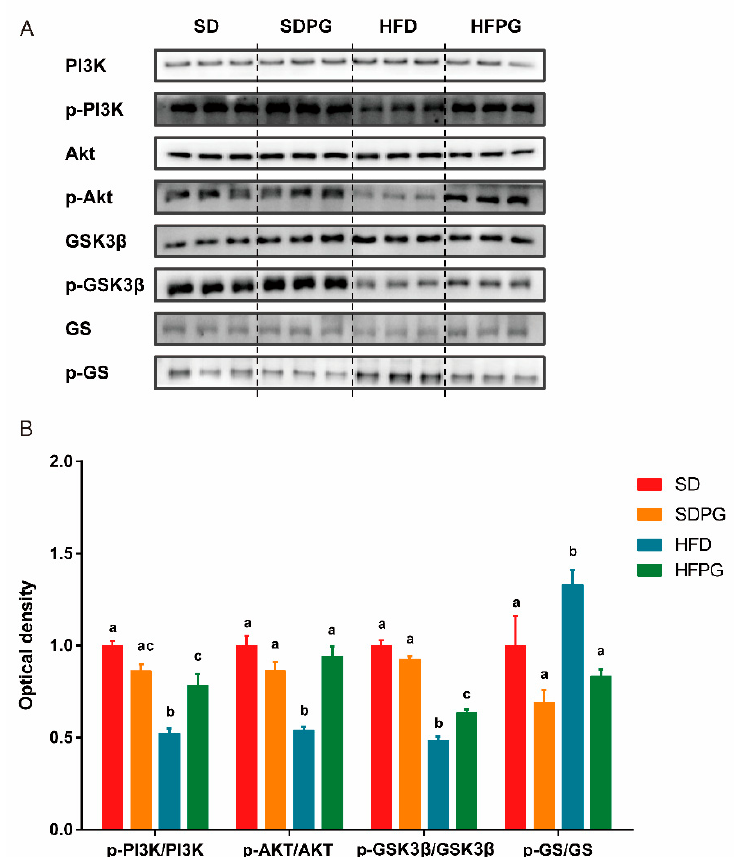
Figure 4. PG enhances hepatic insulin signaling PI3K/Akt/ GSK3 β pathway in HFD-fed mice. ( A ) Western blot analysis for PI3K, p-PI3K, Akt, p-Akt, GSK3 β , p-GSK3 β , GS, and p-GS in liver tissues. ( B ) Fold change in expression of p-PI3K/PI3K, p-Akt/Akt, p-GSK3 β /GSK3 β , and p-GS/GS by densitometry relative to SD group. a, b, c means in the same bar without a common letter differ at p < 0.05.